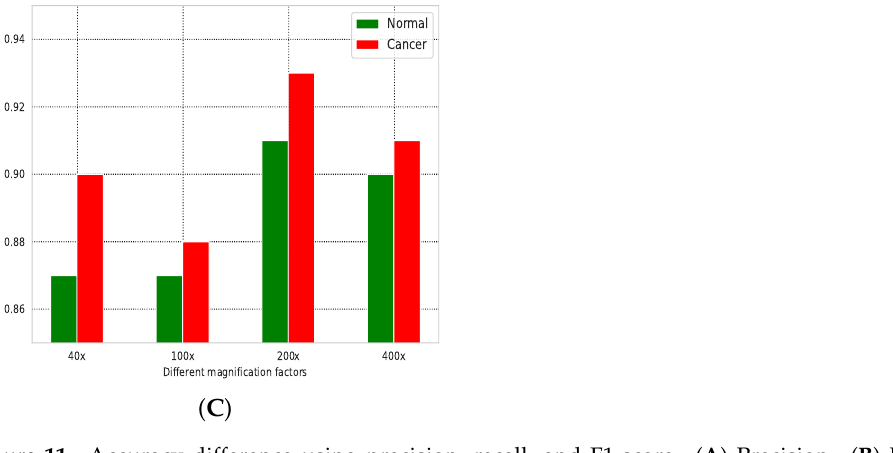
Figure 11. Accuracy difference using precision, recall, and F1-score. ( A ) Precision. ( B ) Recall. ( C ) F1-score.